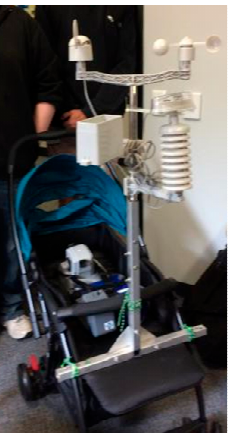
Figure 2. Image of the pram mounted Mobile Air Quality Station (MAQS).